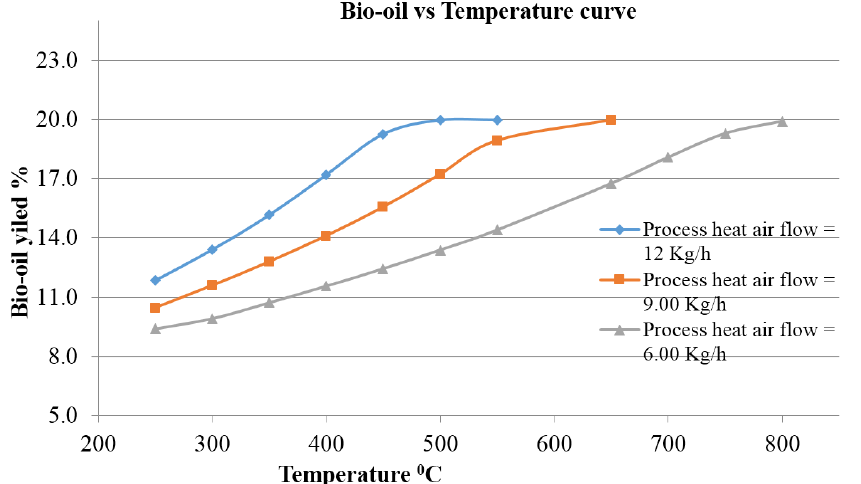
Figure 6. Effect of process heat air flow effect on bio-oil.